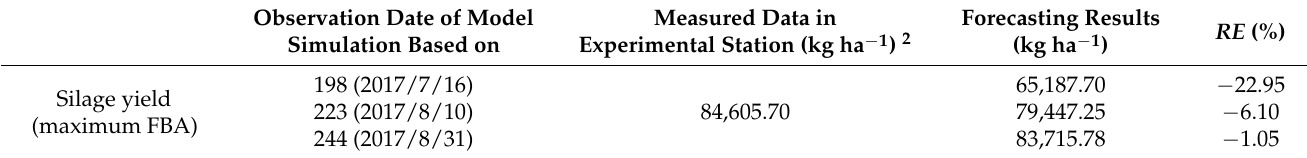
Table 6. Comparisons between the forecasted silage yields (maximum FBAs) based on the field observation 1 in different days and experimental station.